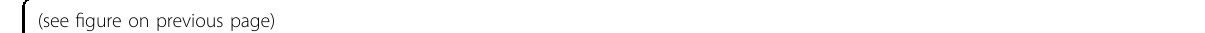
Fig. 4 Improvement of the real-time PCR detection protocol for SARS-CoV-2. Real-time PCR was performed using the SARS-CoV-2 primer sets SARS-CoV-2_IBS_E2, SARS-CoV-2_IBS_RdRP2, SARS-CoV-2_IBS_S2, and SARS-CoV-2_IBS_N1. The GAPDH primer set was used as the IPC primer set. Each row represents each primer set. On the left, each graph represents an ampli fi cation plot, which shows the variation of log ( Δ Rn) values against the PCR cycle number. The Y axis represents the normalized reporter value (Rn), which was calculated as the fl uorescence signal from SYBR Green normalized to the fl uorescence signal of a reference dye. The graphs on the right represent the melting curve plots, which display data collected during a melting curve stage. Peaks in the melting curve may indicate the melting temperature ( T m ) of a target or identify nonspeci fi c PCR ampli fi cation. On the Y axis, the derivative reporter ( − Rn ′ ) was calculated as the negative fi rst derivative of Rn generated by the reporter during PCR ampli fi cation. The green curve is for the Volunteer U cDNA sample. The blue curve is for the SARS-CoV-2 cDNA. The purple curve is for the no- template condition. All data are represented as the mean ± S.E.M.